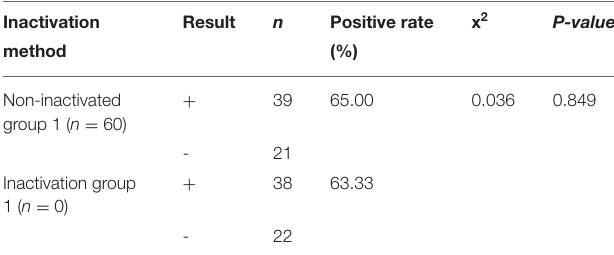
TABLE 5 | Comparison of the positive rates before and after anti-nuclear antibody inactivation [ n